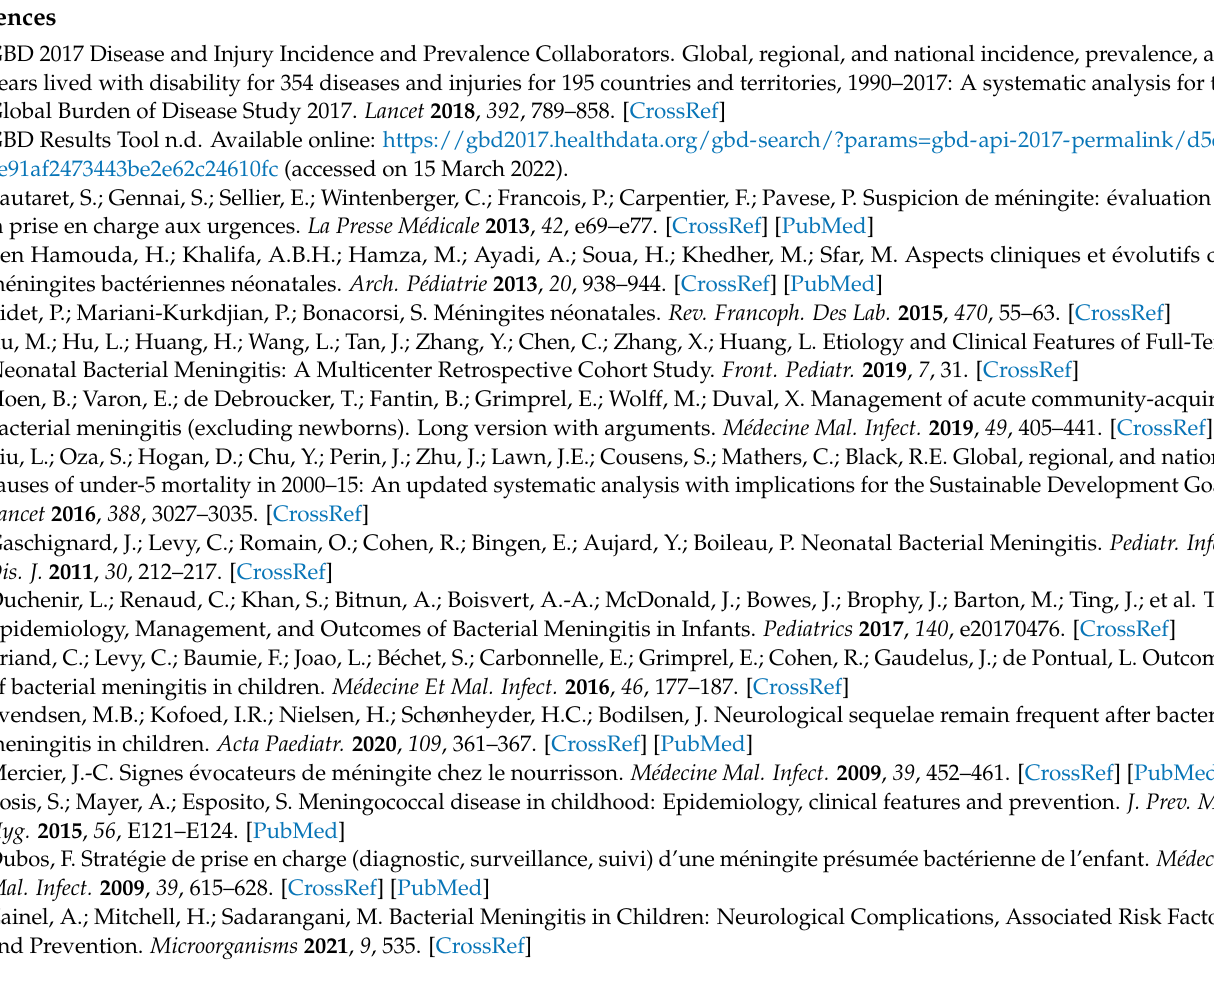
Category Score; Figure S1: Example of seizure on amplitude-integrated EEG trace; Figure S2: Example of a ventilation